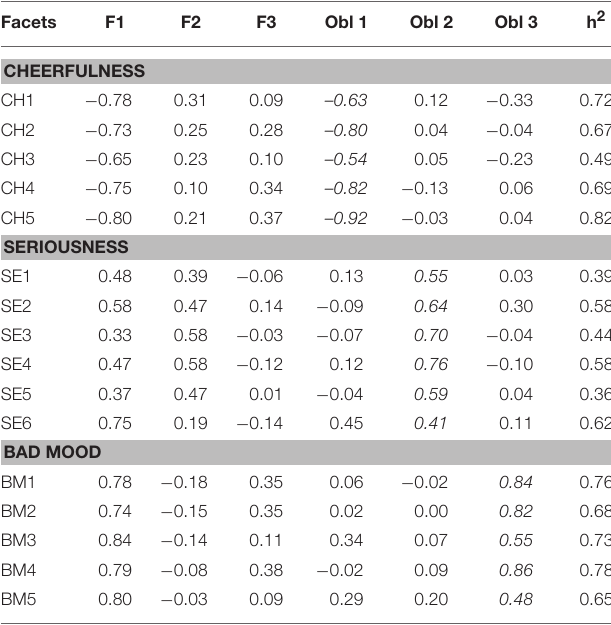
TABLE 5 | Loadings of the STCI–T < 106 > facets on the three unrotated and three obliquely rotated factors in the construction sample.